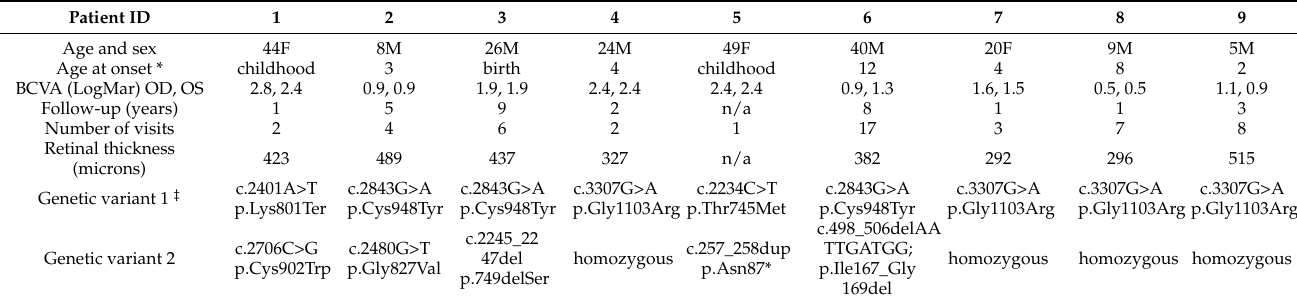
Table 1. Demographic, genetic, and clinical summary of patients.